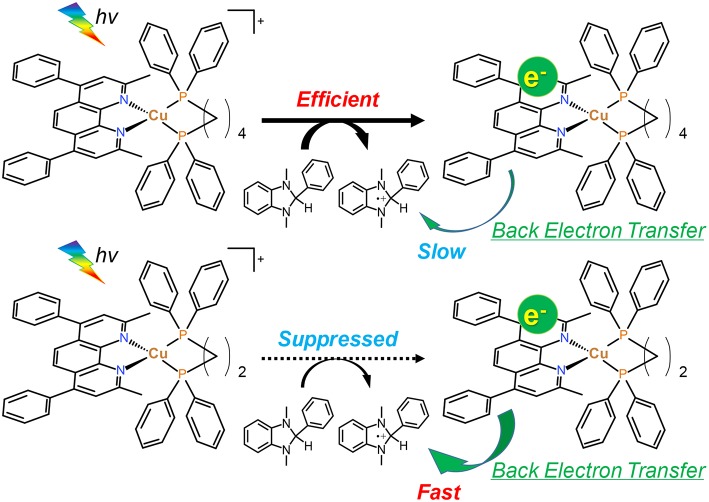
The one-electron reduction processes of Cu(dppb) and Cu(dppe).